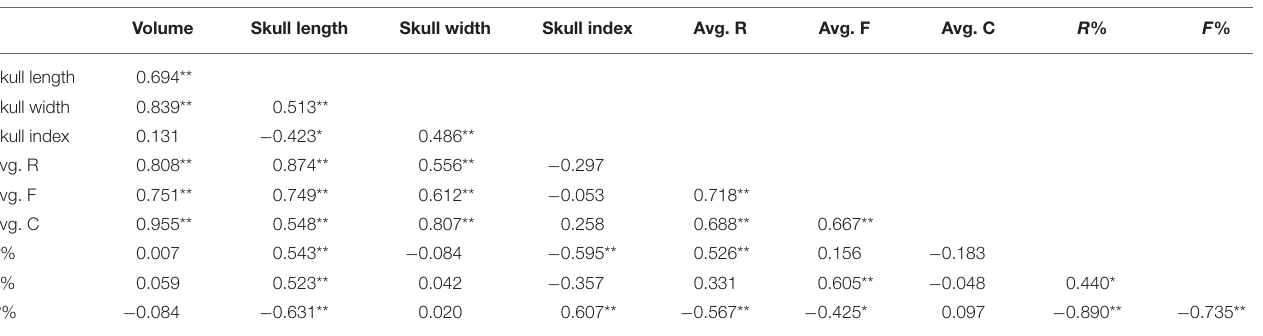
TABLE 1 | Spearman’s correlations between skull and endocast